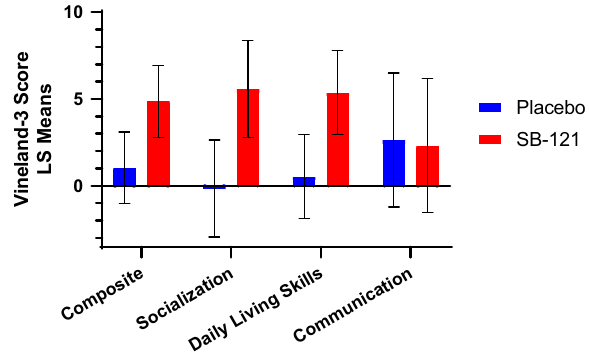
Figure 2. Vineland-3 change from baseline scores (LS means, SEM).